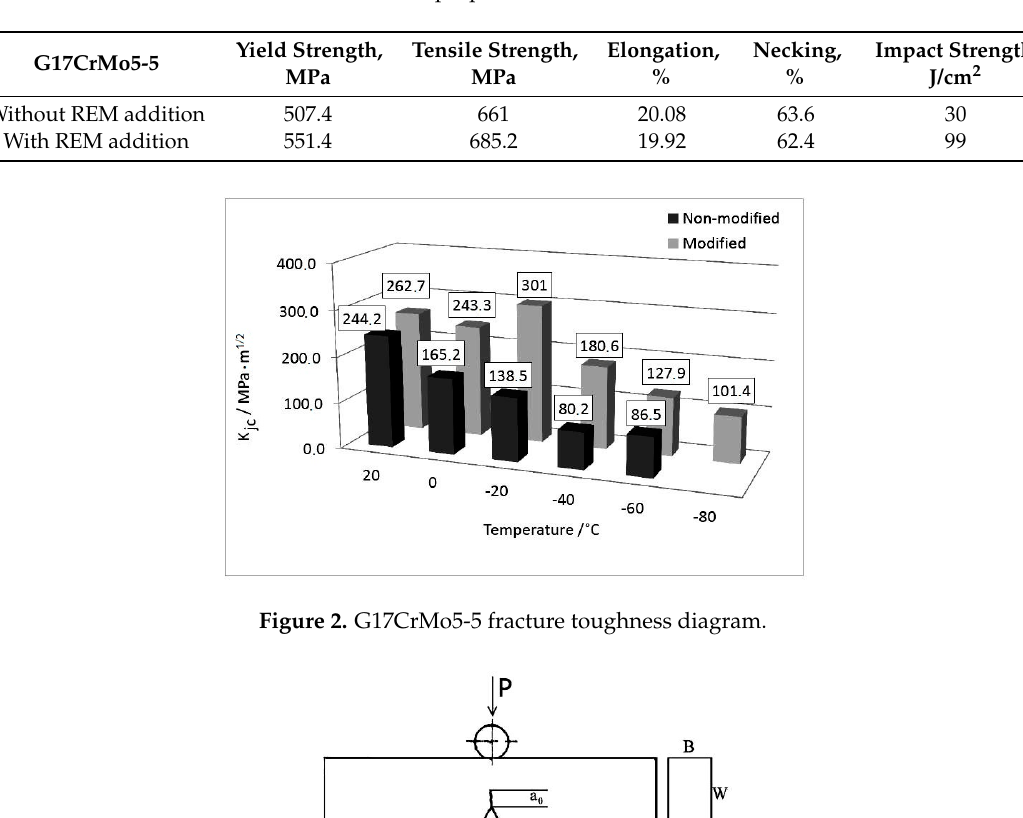
Table 2. Mechanical properties of G17CrMo5-5 cast steel.